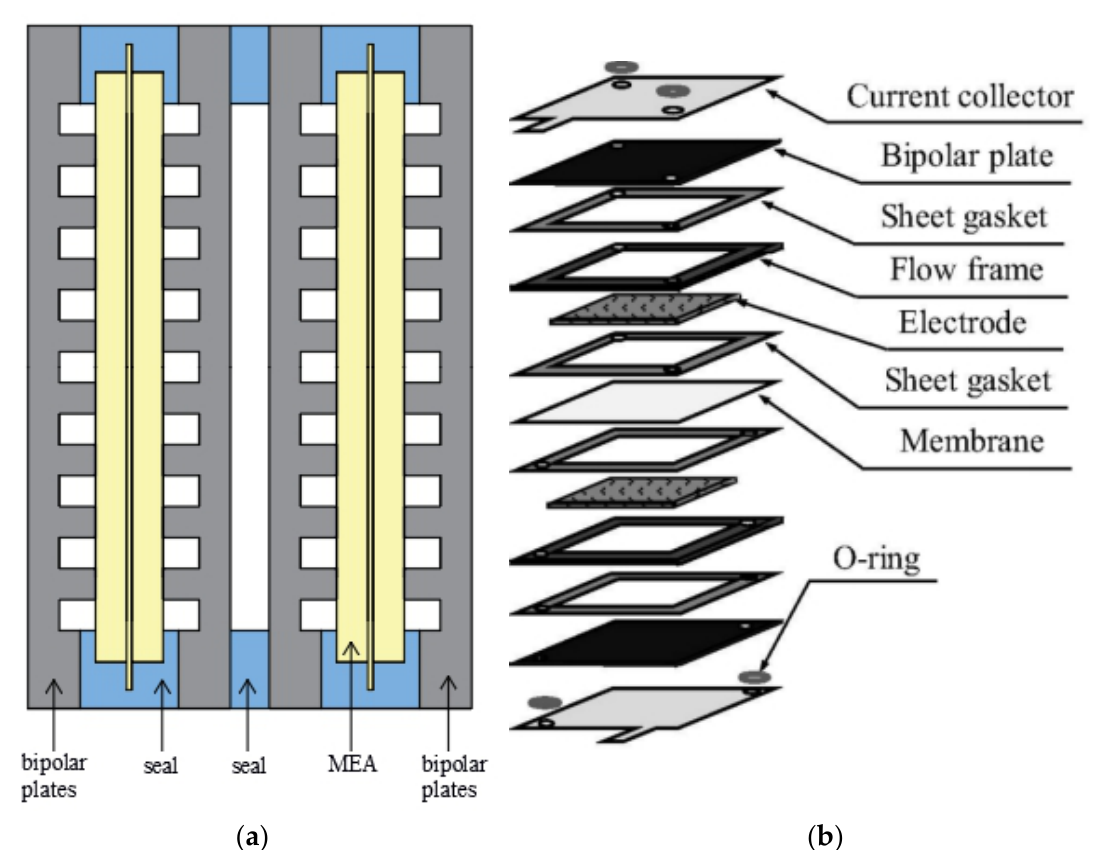
Figure 4. Schematics of the structures of: ( a ) proton exchange membrane fuel cells (PEMFCs); ( b ) redox flow batteries (RFBs) [20] (Copyright: © 2021 by Elsevier. Licensee Ms. Xiaoyu Huang. License Number 5181940503674. License date 4 November 2021).